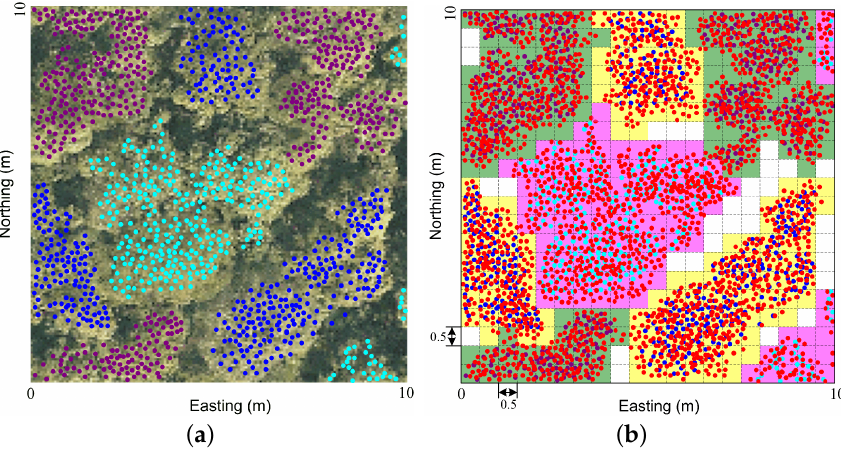
Figure 3. An example of the rough partitioning for a portion of a typical subplot (DHS0101). This is a downward-looking view of the area. ( a ) Fixed bandwidth mean shift clustering results overlaid onto a digital orthophoto map (DOM). Spatially adjacent clusters are rendered in different colors. ( b ) Rough partitioning of the forest area based on the small square grouping technique. Connected squares marked in the same color belong to the same